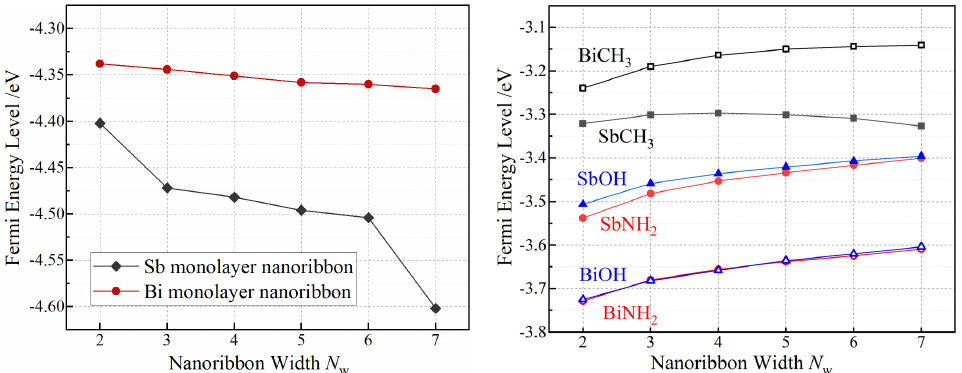
Figure 4. Fermi energy levels in dependence on nanoribbon width ( N w = 2~7) of Sb or Bi ( left panel ) and SbXH n or BiXH n ( right panel ) monolayer zigzag nanoribbons in reference to vacuum free electron energy level.